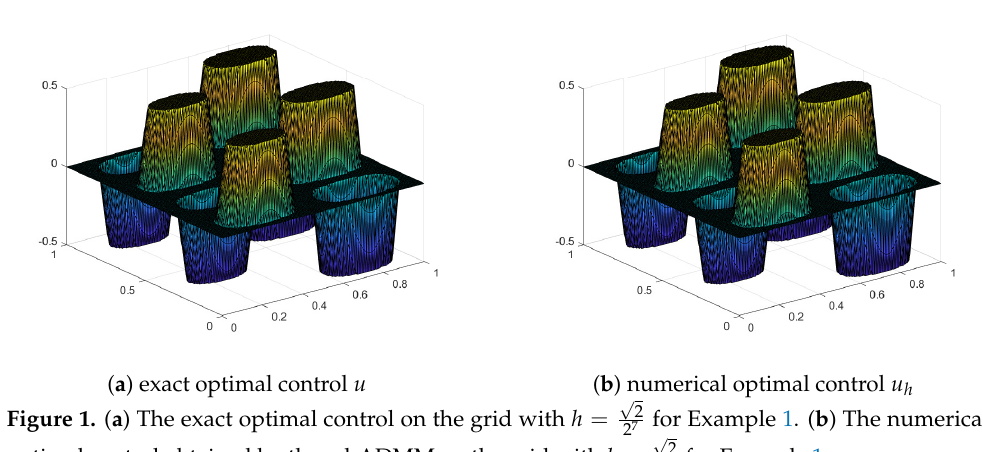
Figure 1. ( a ) The exact optimal control on the grid with h = optimal control obtained by the mhADMM on the grid with h =